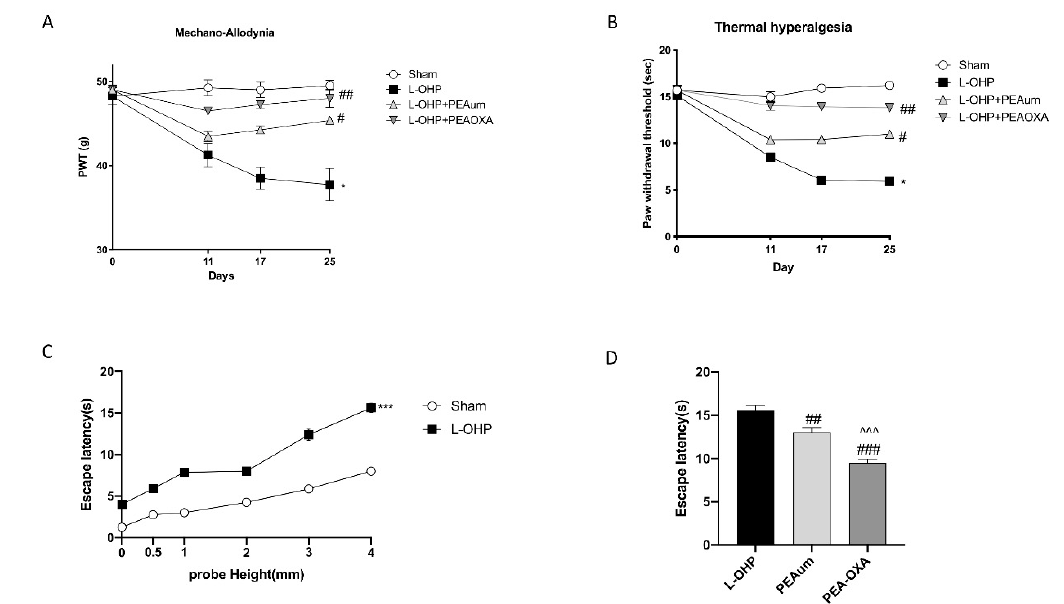
Figure 1. Effect of 2-pentadecyl-2-oxazoline (PEA-OXA) on allodynia and hyperalgesia. When compared to day 0, administration of oxaliplatin (L-OHP) but not saline resulted in a time-dependent development of mechano-allodynia ( A ) and mechano-hyperalgesia ( B ). The development of mechano-hypersensitivity was blocked by daily oral injections (Days 0–4) of PEA-OXA (10 mg/kg/day), more significative then ultramicronized palmitoylethanolamide (PEAum) (10 mg/kg). The Y -axis corresponding to paw withdrawal threshold (PWT) is cropped for clarity. ( C ) Time course of escape latencies of chemotherapy-induced peripheral neuropathy (CIPN) and control rats measured with 3 mm probe height after weekly injections of L-OHP or saline. ( D ) Oral administration of PEA-OXA at 10 mg/kg, more than PEAum, significantly reduced escape latencies when injected with L-OHP. Data are representative of at least three independent experiments. Values are means ± standard error of the mean (SEM) of 20 animals for each group. * p < 0.05 vs. sham; # p < 0.05 vs. L-OHP; ## p < 0.01 vs. L-OHP; ### p < 0.001 vs. L-OHP; ˆˆˆ p < 0.001 vs. PEAum; *** p <